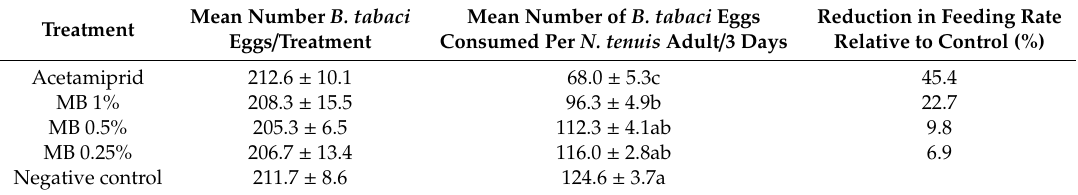
Table 2. E ff ects of methyl benzoate (MB) on the feeding rates of adults of Nesidiocoris tenuis consuming eggs of Bemisia tabaci.